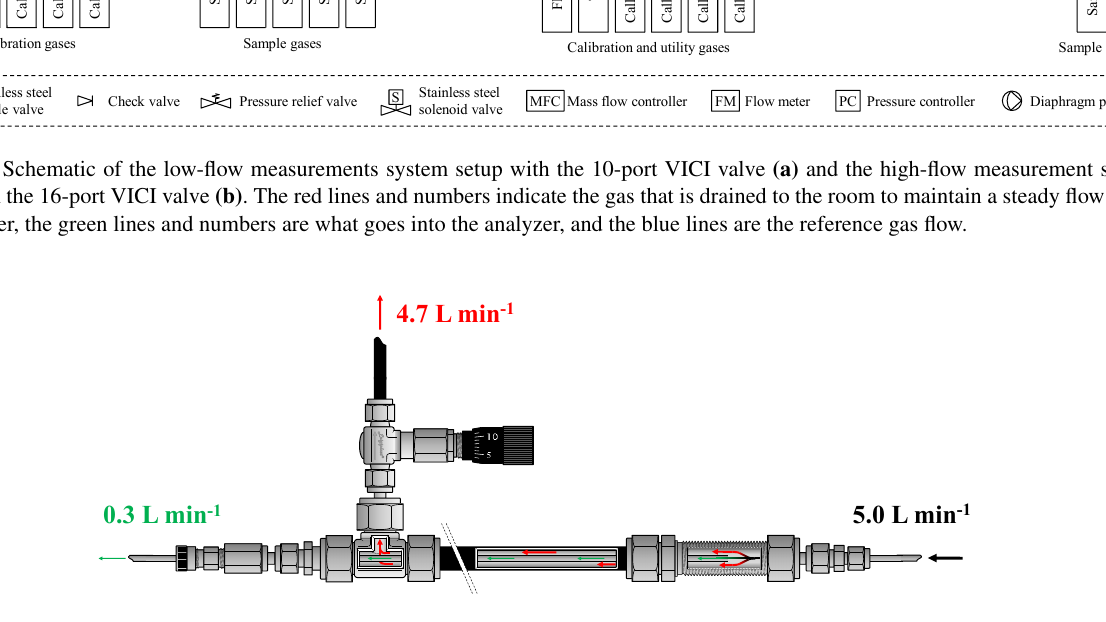
Figure 2. Flow schematic of the high-flow inlet system. The sample gas enters on the right side at 5.0Lmin − 1 . A small aliquot of 0.3Lmin − 1 goes to the analyzer, and the remainder of 4.7Lmin − 1 goes to the exhaust. The ratio between the gas going to the analyzer and the exhaust, respectively, is set by the dimensions of the inner and outer tube and can be adjusted by the needle valve on the exhaust